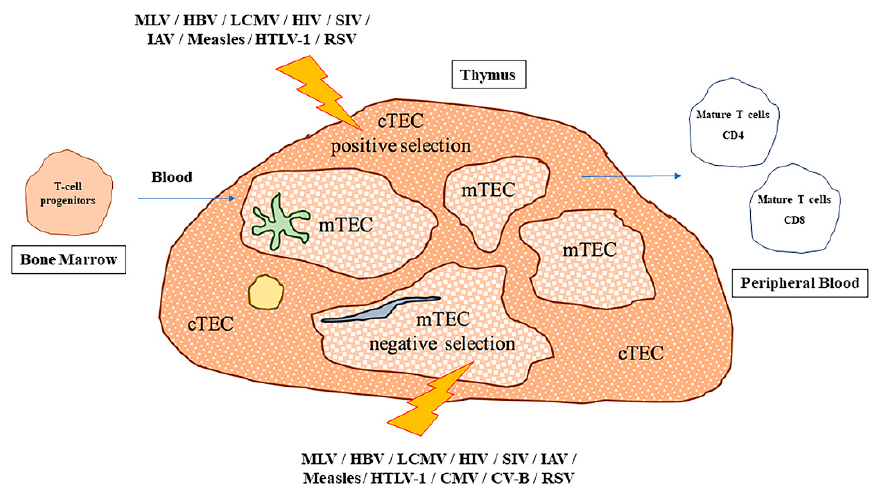
Figure 1. Impact of viral infections on intra-thymic T cell development. Two major populations of thymic epithelial cells (TECs) are present in the thymic parenchyma. In particular, cortical TEC (cTEC) cells are identified in the cortical compartment of the parenchyma, whereas medullary TEC (mTEC) cells are located internally. Dendritic cells (DCs, shown in green), fibroblasts (blue) and macrophages (yellow), contribute to the tissue organization. In humans, during the maturation process, bone marrow-derived T-cell progenitors arrive in the thymus via the bloodstream, where cTEC cells contribute to positive selection maturation, and mTEC cells contribute to the negative selection process, respectively. Also, DCs are likely responsible for negative selection in the cortex. Once the selection has been successfully completed and self-reactive cells have been removed by apoptosis, mature CD4 + or CD8 + T cells leave the thymus to populate the peripheral blood and secondary lymphoid organs. Viral infections are able to affect thymus functionality in multiple ways, but the most severe effects are observed when positive or negative selection is impaired, as these processes drive key steps of T-cell development. In the figure, lightning bolts indicate which viruses can specifically target and influence the activity of cTEC or mTEC populations.